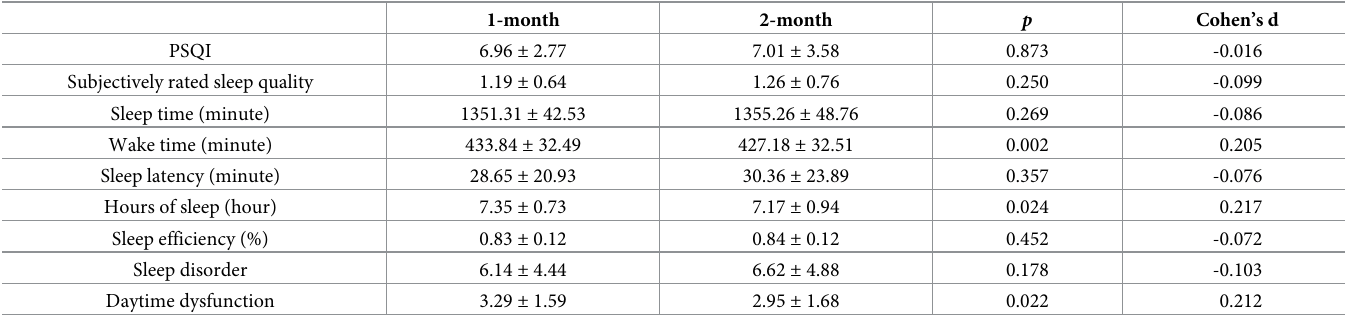
Table 1. Descriptive results of sleep quality of athletes in closed-loop management ( M ± SD ).